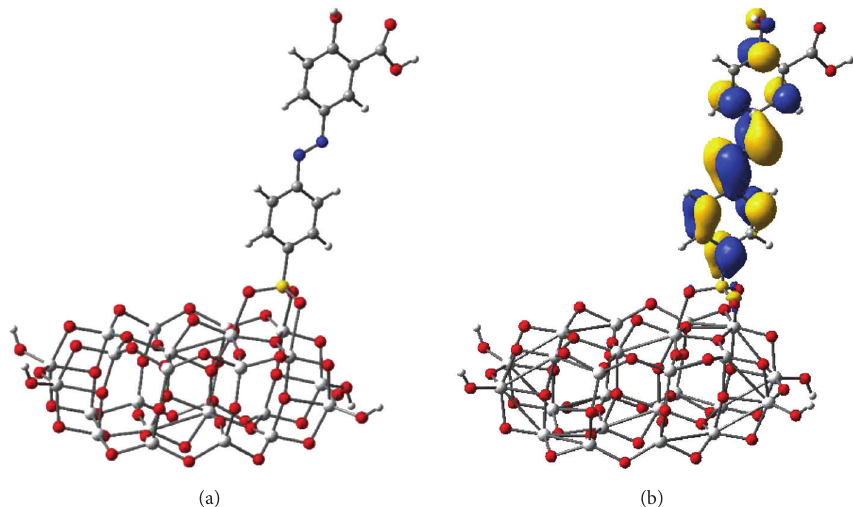
Figure10:(a)OptimizedstructureoftheH2H3-ACY − -oxidesystem,withanchoringthroughthesulfonicgroup,calculatedatDFT/B3LYP/3- 21G(d) level. (b) Isodensity surfaces (0.03e/bohr 3 ) of the MO corresponding to the excited state of the sensitizer key molecular orbitals of the H2H3-ACY − dye adsorbed on the TiO 2 nanocluster calculated at DFT/B3LYP/DZVP level in water.